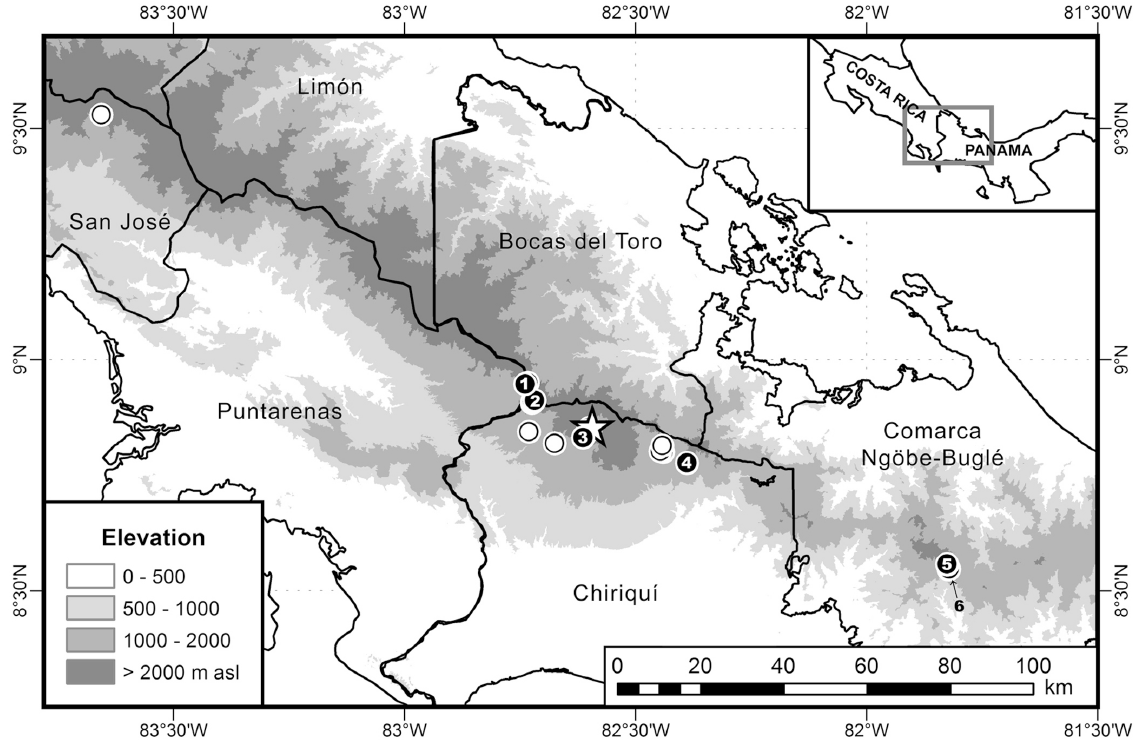
Anolis salvini in Costa Rica and Panama: The white star represents the type locality of